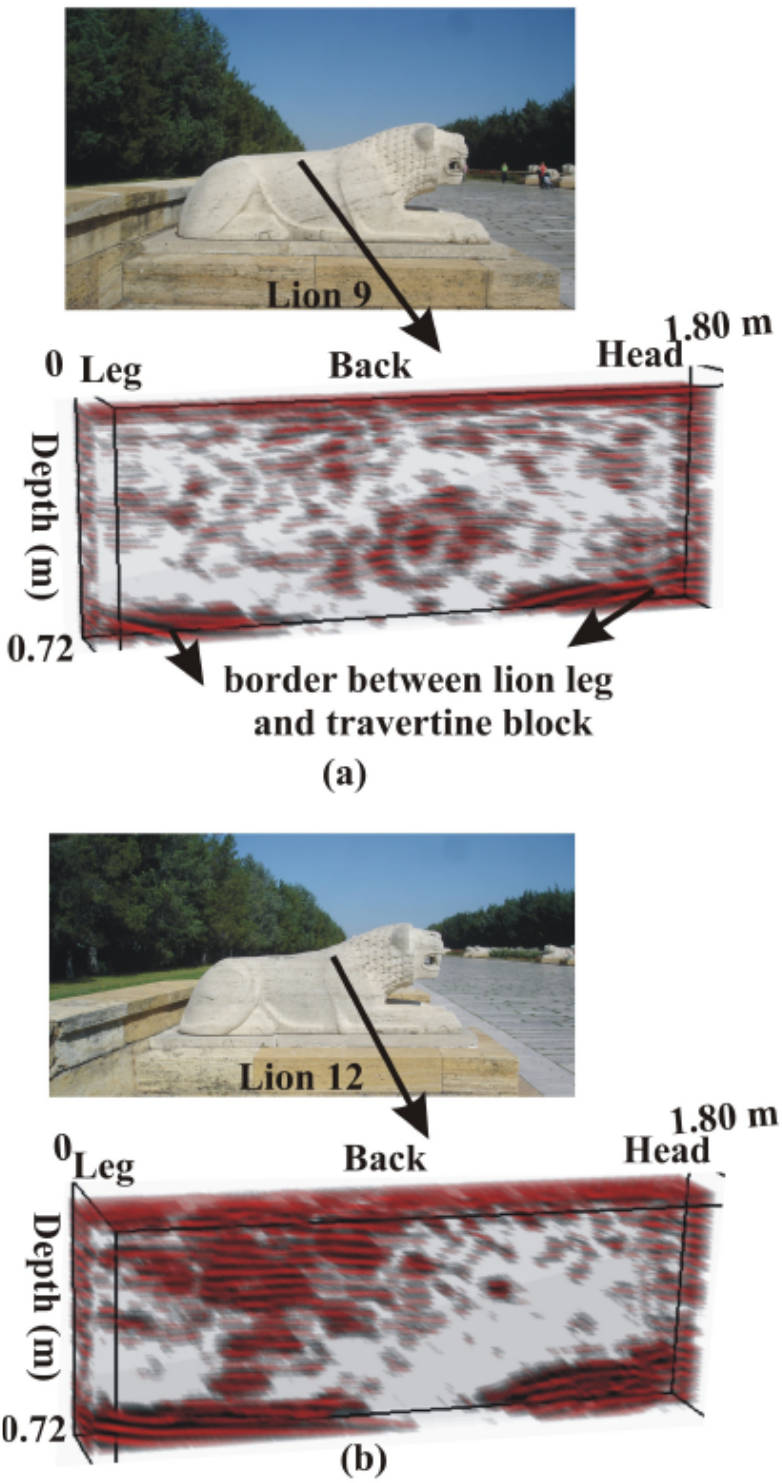
Fig. 14. (a) The transparent 3-D visualization results with the fractures and large cavities of the ninth lion statue and (b) the twelfth lion